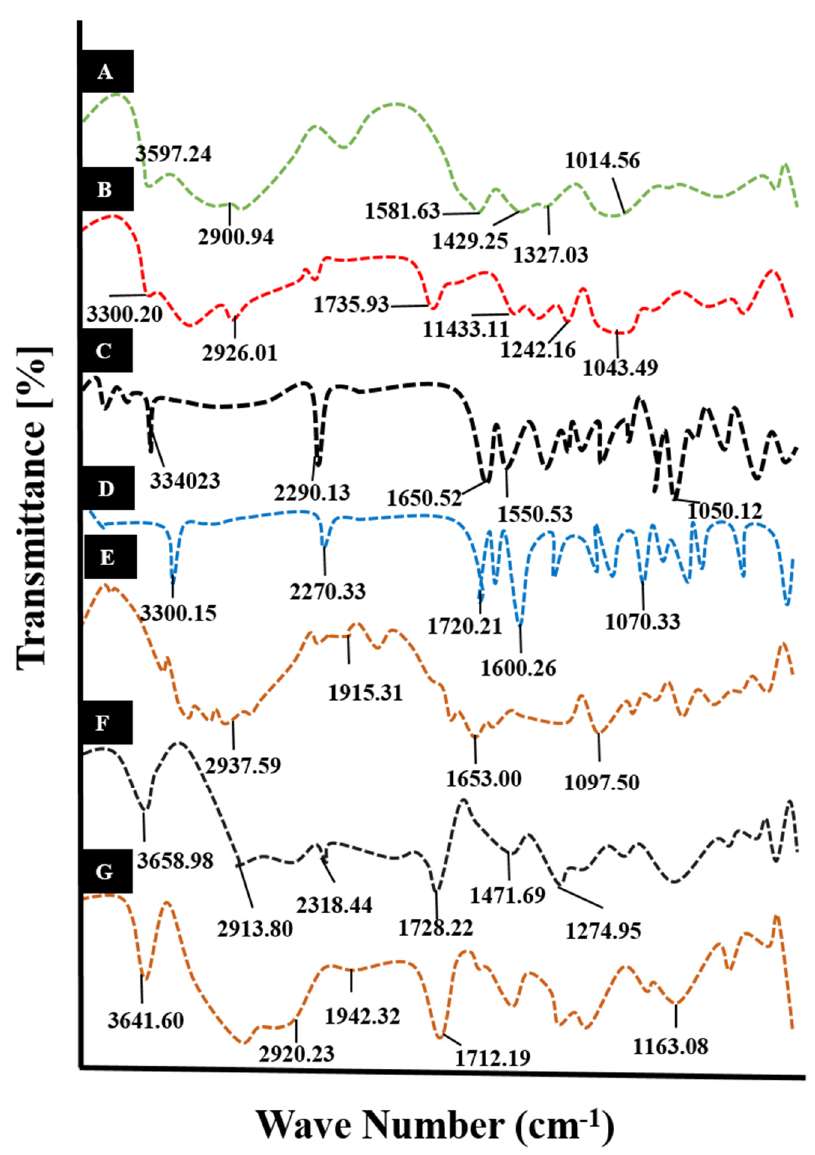
Figure 2. FTIR spectra of ( A ) Na-CMC, ( B ) pectin, ( C ) cytarabine, ( D ) MBA, ( E ) physical mixture, ( F ) unloaded hydrogel, and ( G ) cytarabine-loaded hydrogel.